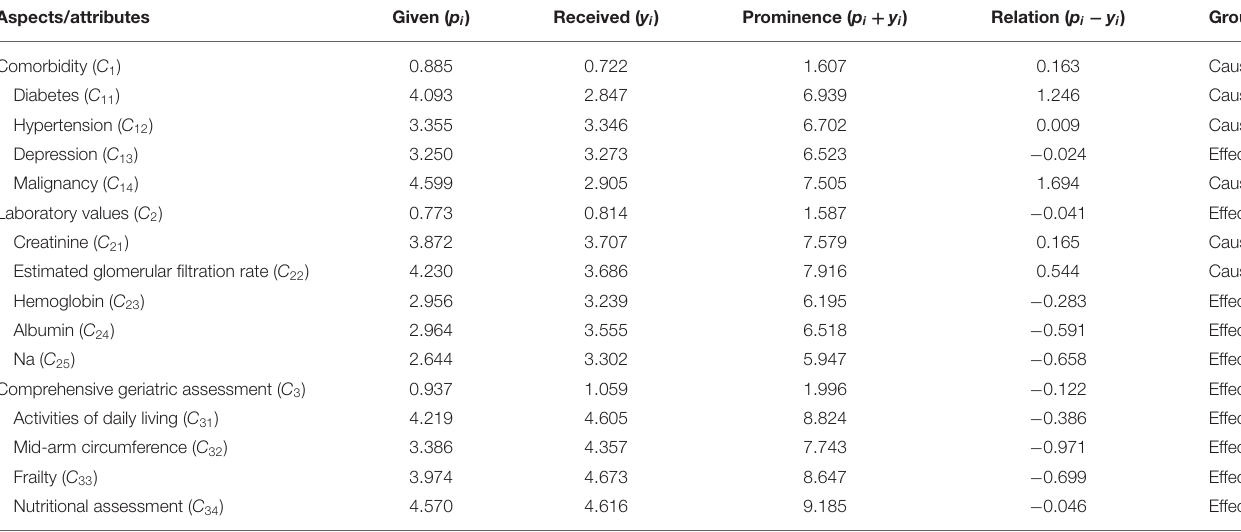
TABLE 4 | The influential indicators regarding aspects and